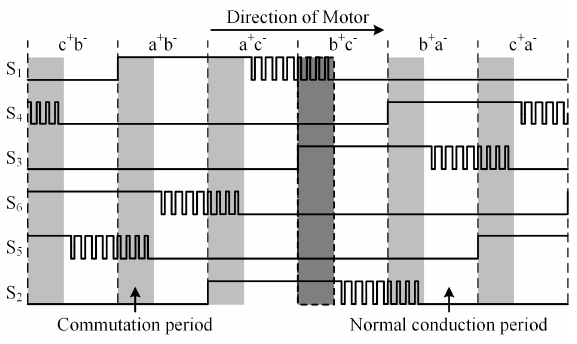
Figure 2. Modulation in high-speed region.